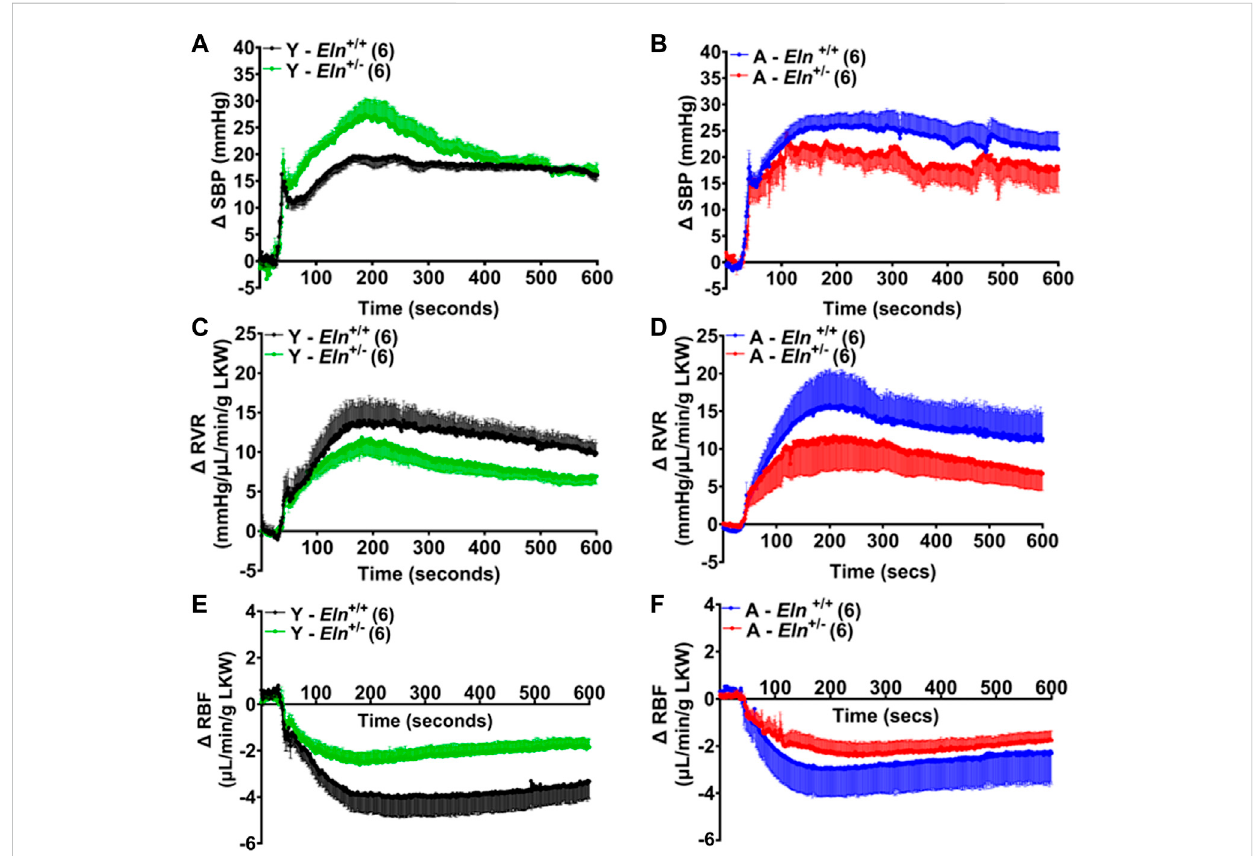
FIGURE 5 Time course of blood pressure and renal hemodynamic response to simultaneous occlusion of the celiac and superior mesenteric arteries. Blood pressureincreasedsharplyinbothyoung (A) andaged (B) Eln +/+ and Eln +/ − mice.Thiswasaccompaniedbyincreasedrenalvascularresistance(RVR, (C,D) and a pronounced decrease in renal blood fl ow (RBF, (E,F) . Data are presented as mean ± s.e.m. Y, young; A, aged; LKW, left kidney